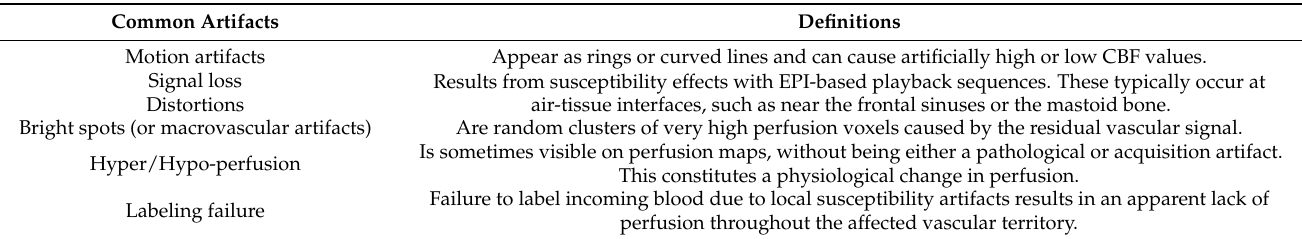
Table 2. Common artifacts and their definitions.